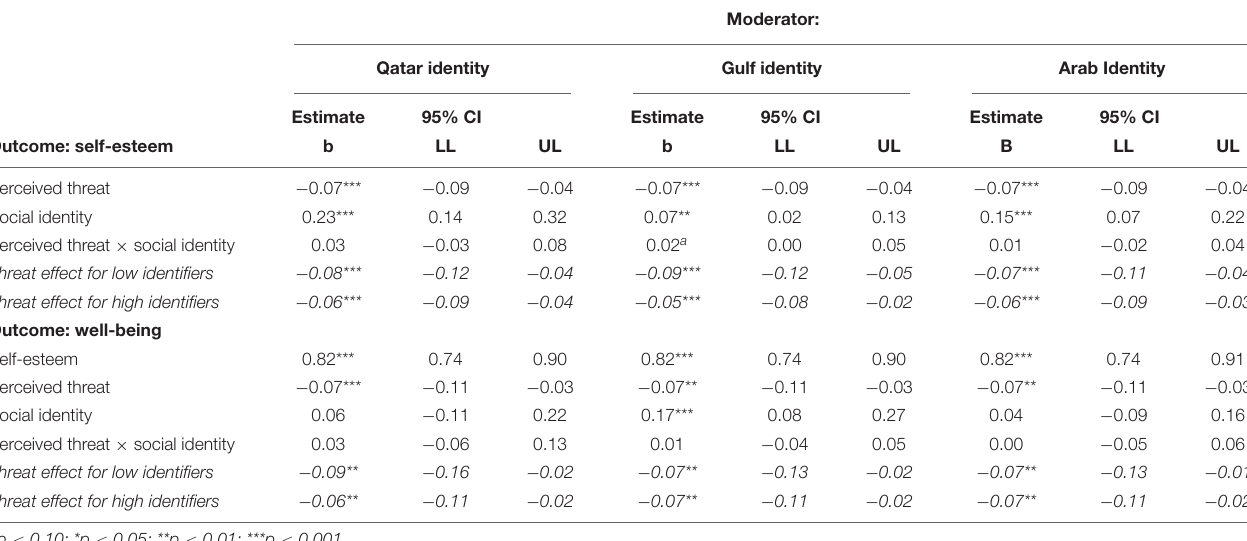
TABLE 2 | Unstandardized estimates and 95% confidence intervals of moderated mediation analyses on self-esteem (upper panel) and well-being (lower panel) for each facet of social identity separately.